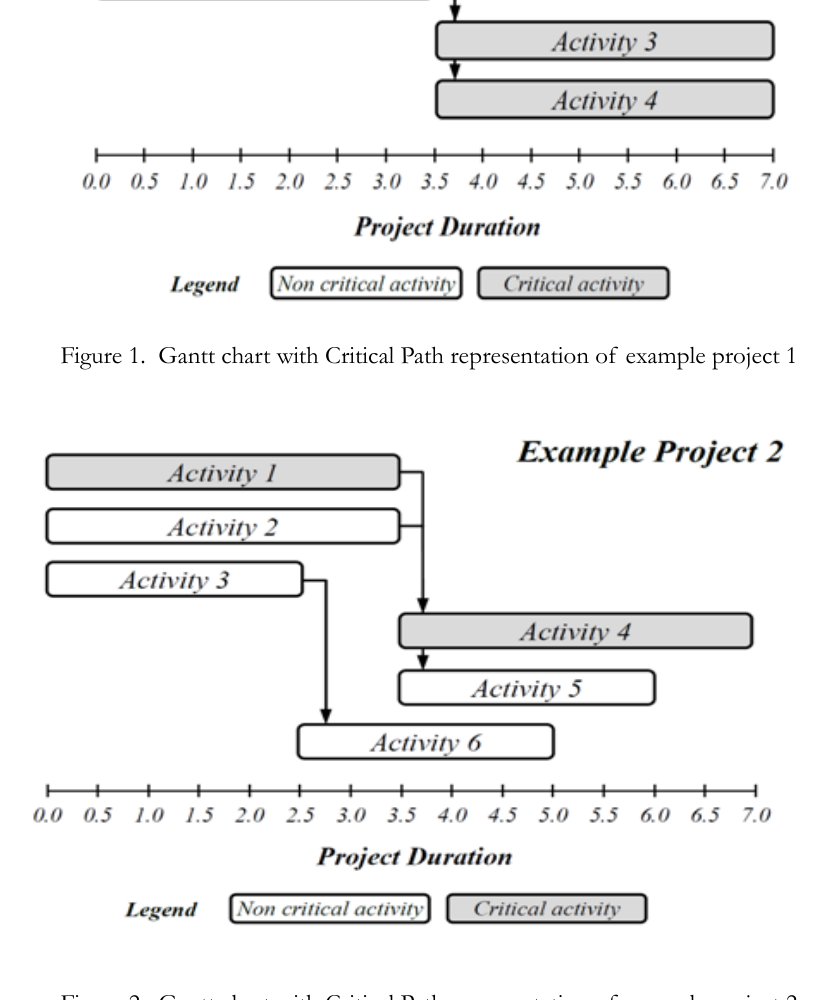
Figure 2. Gantt chart with Critical Path representation of example project